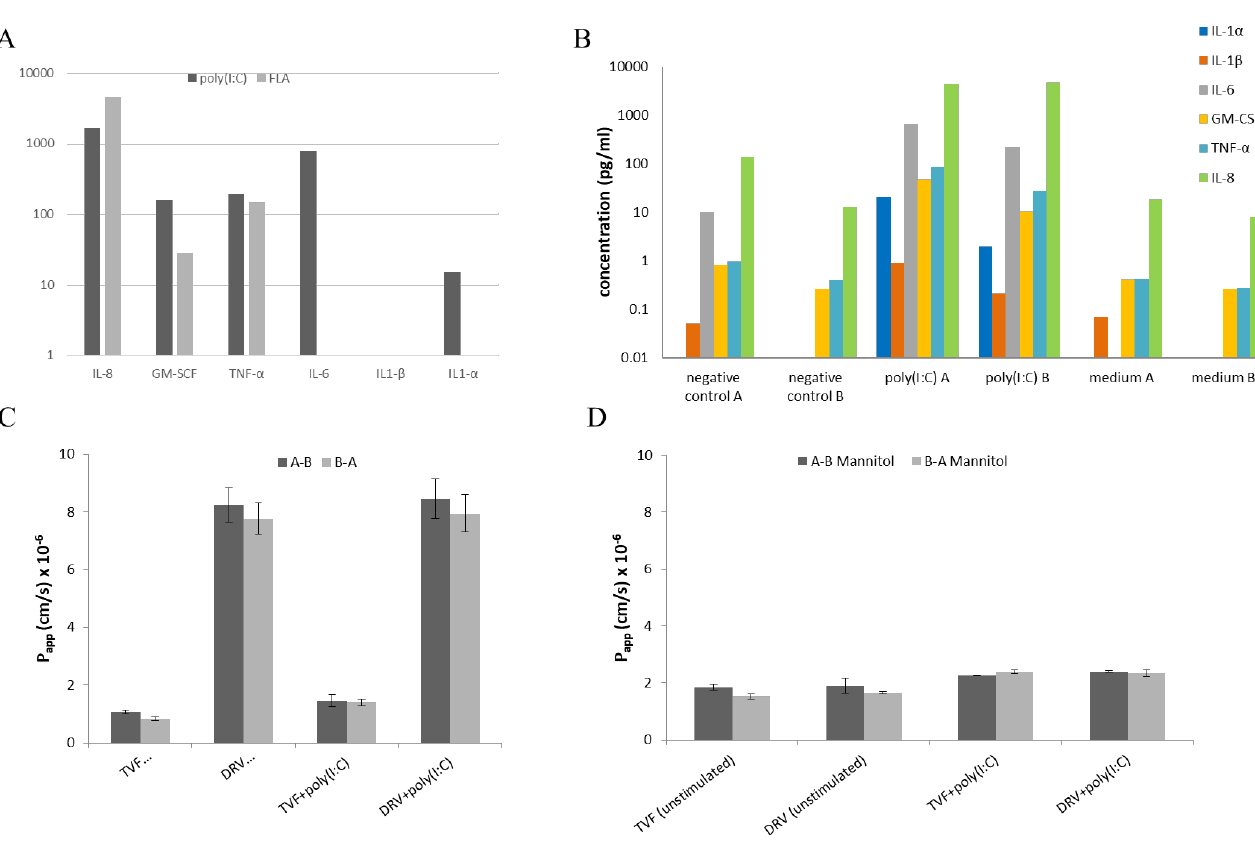
Figure 4. Effect of PAMP stimulation on pro-inflammatory cytokine production and drug permeability in the HEC-1A model. ( A ) Pro-inflammatory cytokine production in response to stimulation with poly(I:C) and flagellin (FLA). ( B ) Pro-inflammatory cytokine production in the donor (A) and receiver (B) compartments on stimulation with poly(I:C) in comparison with stimulation with an irrelevant protein and medium alone. ( C ) Absorptive (A-B) and secretory (B-A) permeabilities of tenovofir (TNF) and darunavir (DVR) in cells stimulated with poly(I:C) (25 μg/mL) in comparison with unstimulated cells. ( D ) Absorptive and secretory permeabilities of mannitol used as paracellular transport markers in the tenofovir and darunavir permeability assays.